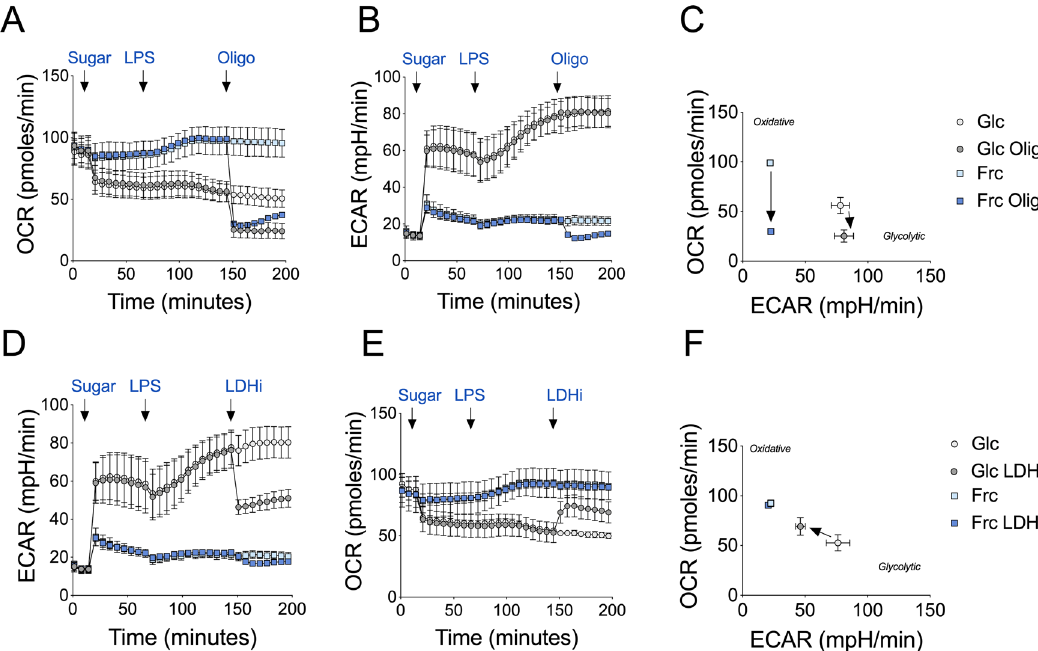
Fig. 2 Fructose treatment enhances oxidative metabolism. Seahorse extracellular fl ux analysis of A OCR and B ECAR in monocytes before and following injections of glucose or fructose (both 11.1 mM), LPS (10 ng/mL) and oligomycin (1 µ M) at the time points indicated. C OCR versus ECAR map of average of a single value pre- and post-oligomycin injection for glucose- and fructose-treated monocytes. Arrows indicate the shift in metabolism upon inhibitor exposure. Analysis of D ECAR and E OCR in monocytes as A with a fi nal injection of a lactate dehydrogenase inhibitor (GSK2837808A, LDHi; 10 µ M). F OCR versus ECAR map as C with pre- and post- LDHi injection. Data are representative of three independent experiments and are expressed as mean ± SEM. Source data are provided as a Source Data fi